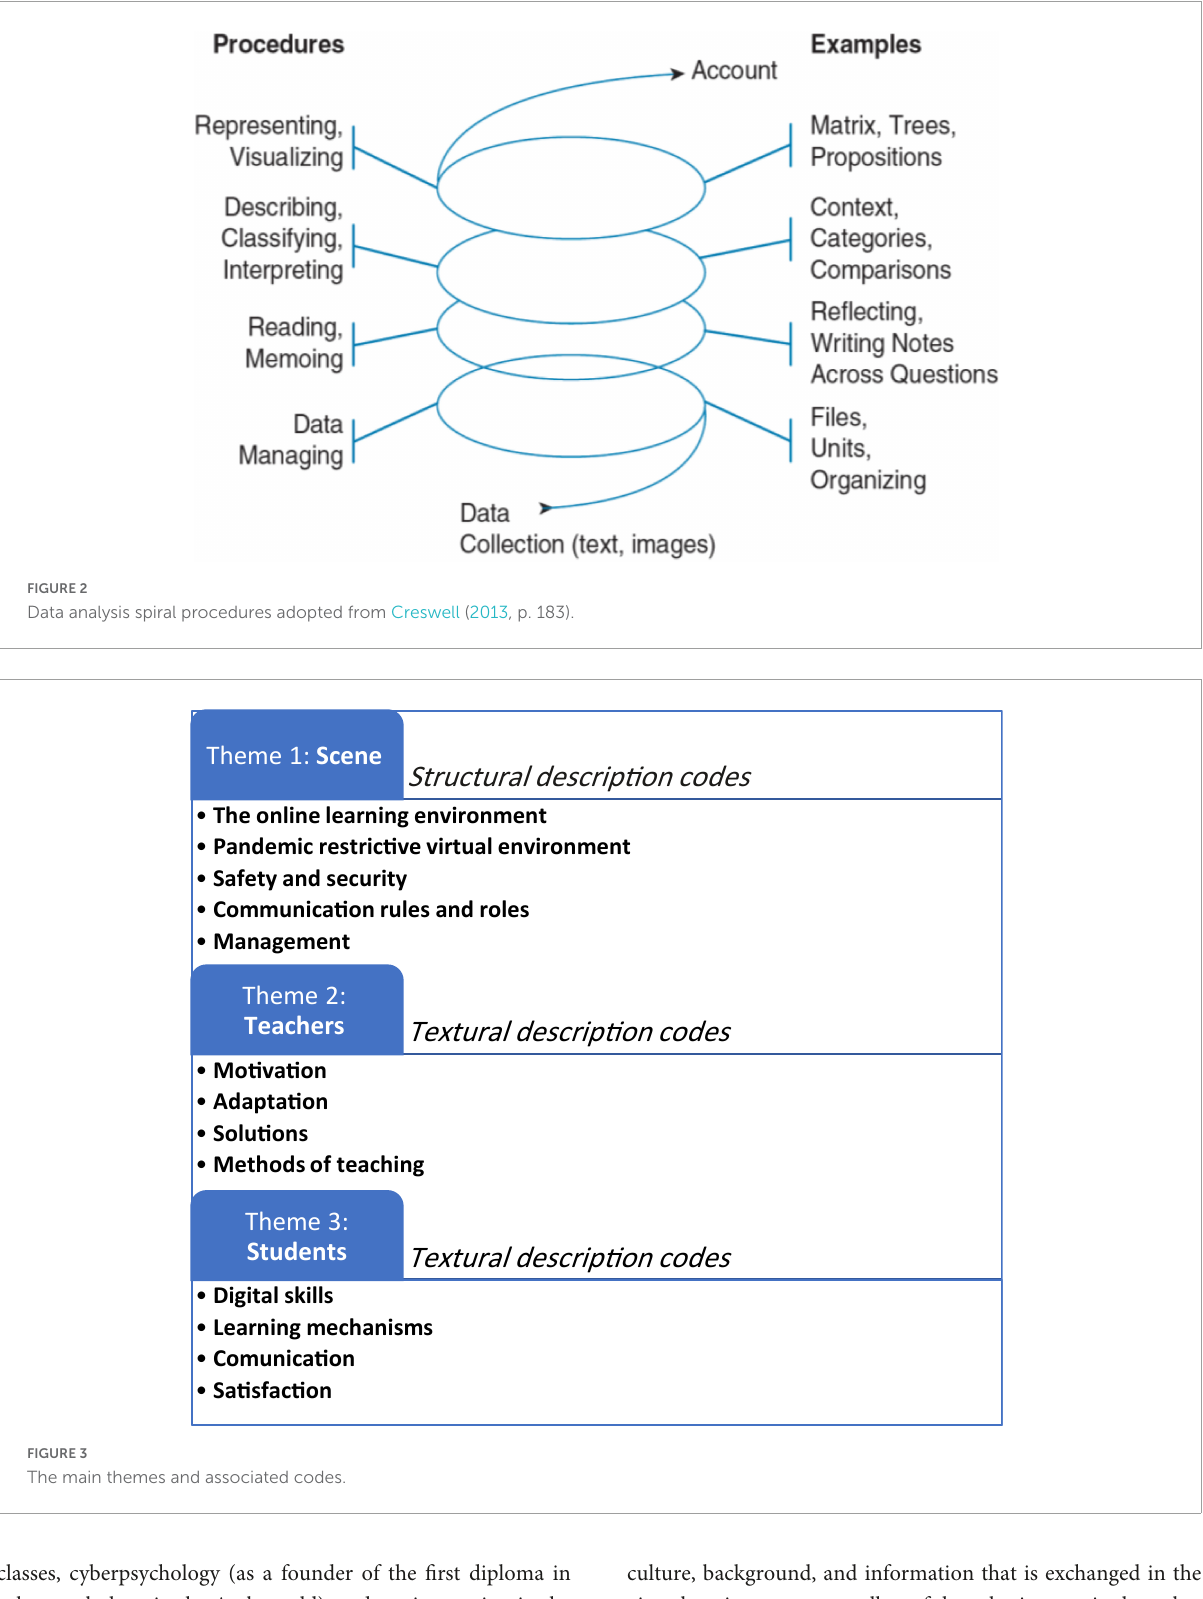
classes, cyberpsychology (as a founder of the first diploma in cyberpsychology in the Arab world), and my immersion in the field of robotics as a teaching method made me aware of the